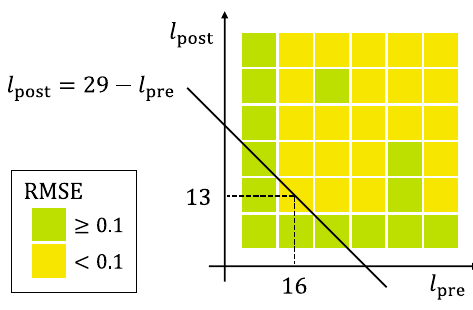
29 − l passing through the area post ¼ pre 16 and l 13 ( l 29 pre ¼ post ¼ total ¼